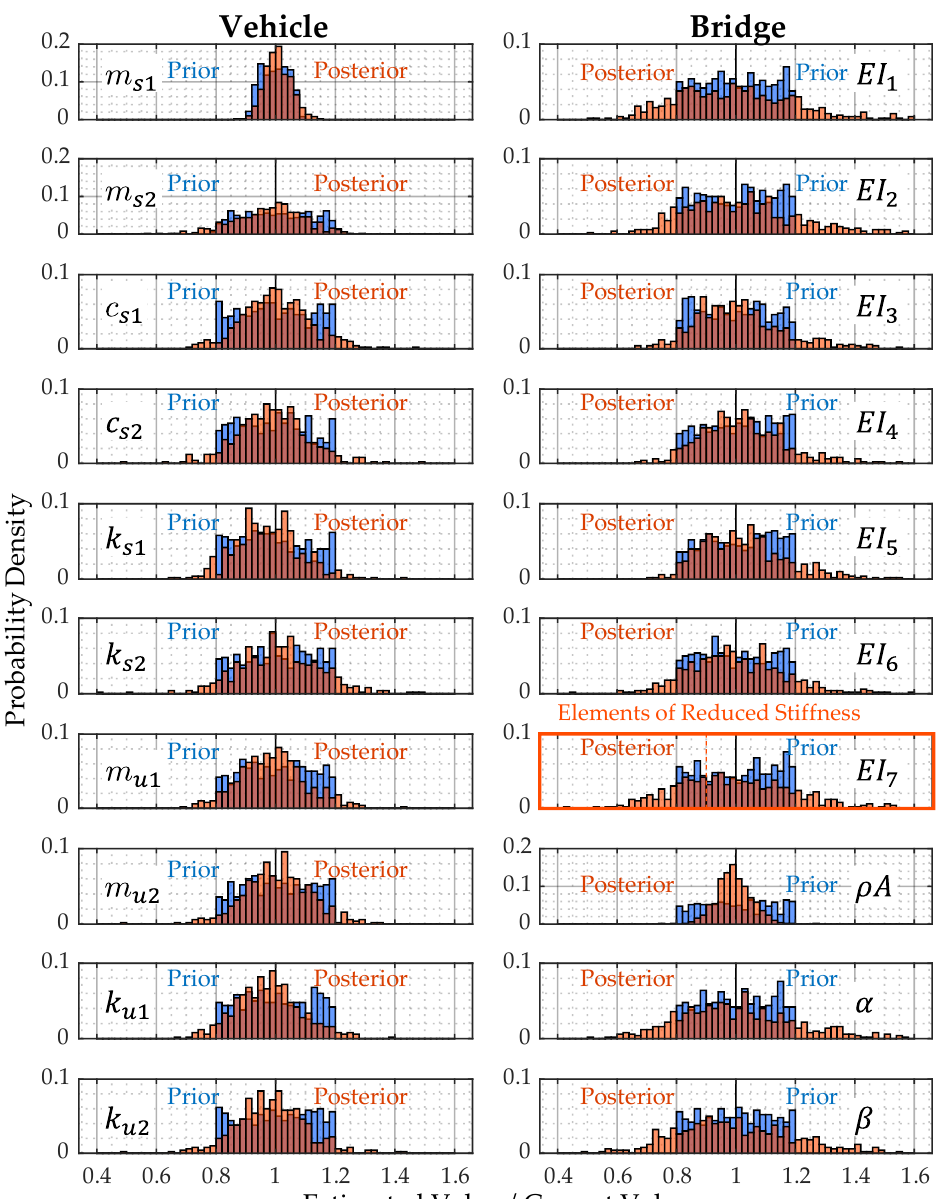
Figure A12. The application results of the PRE method in the case of Scenario 10 (stiffness decrease section: 6𝐿/7 ~ 𝐿 , decrease rate: 10%).